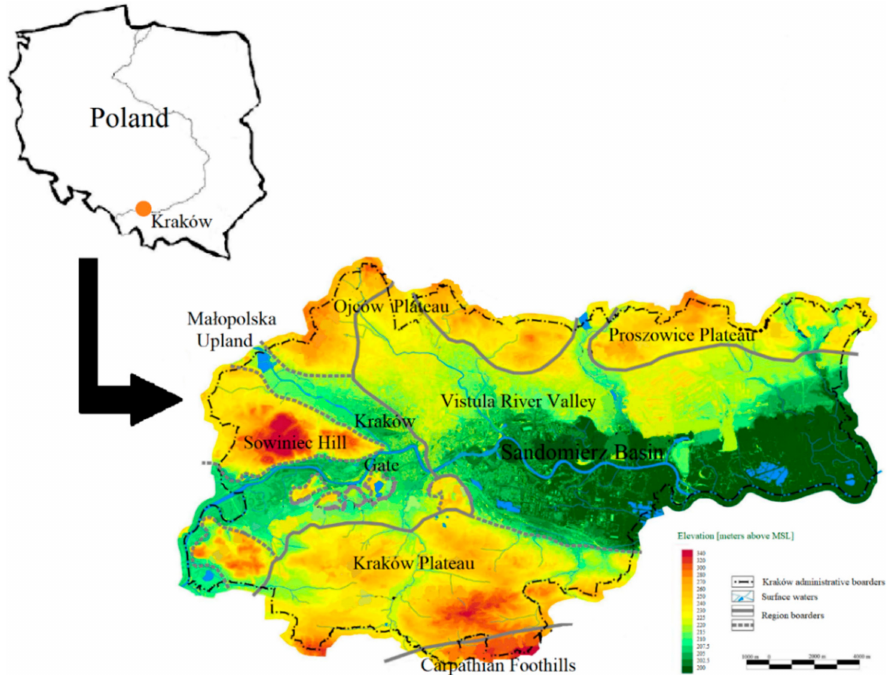
Figure 1. Geographic location of Krak ó w in Poland and elevation changes of the city (modified after